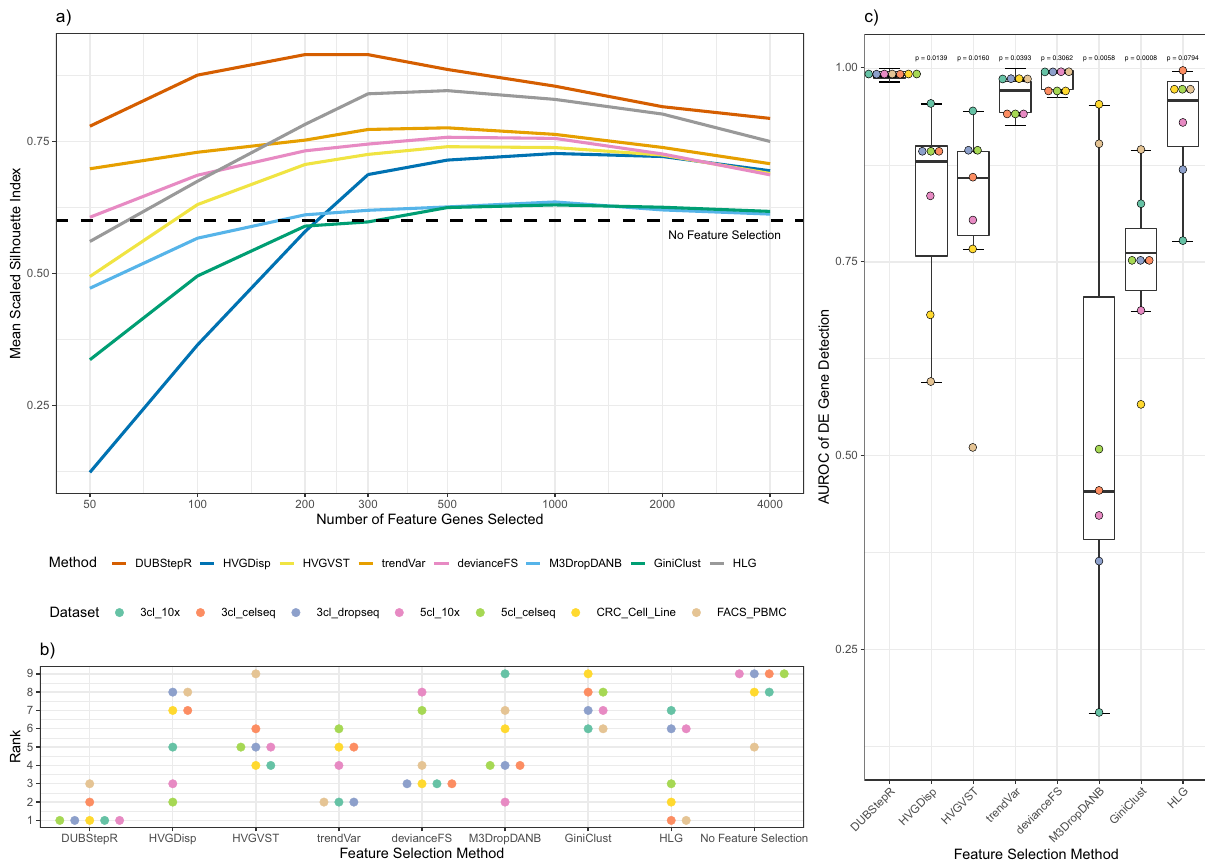
Fig. 4 Benchmarking feature selection methods. a Mean scaled silhouette index of feature sets ranging from 50 to 4000 features. b Rank distribution of feature selection methods. For each dataset, the methods are ranked from 1 to 9 by their best SI across all feature set sizes. c AUROC of DE gene detection. For all boxes, the middle line represents the median, the lower and upper box limits correspond to the fi rst and third quartiles, the upper and lower whiskers extend upto 1.5*IQR from the top and bottom of the box, respectively (where IQR is the inter-quartile range). Points beyond the whiskers are outliers and are plotted individually. All p -values were calculated using two-sided Student ’ s T-tests ( n = 7). Refer to Supp. Table S6 for details regarding the